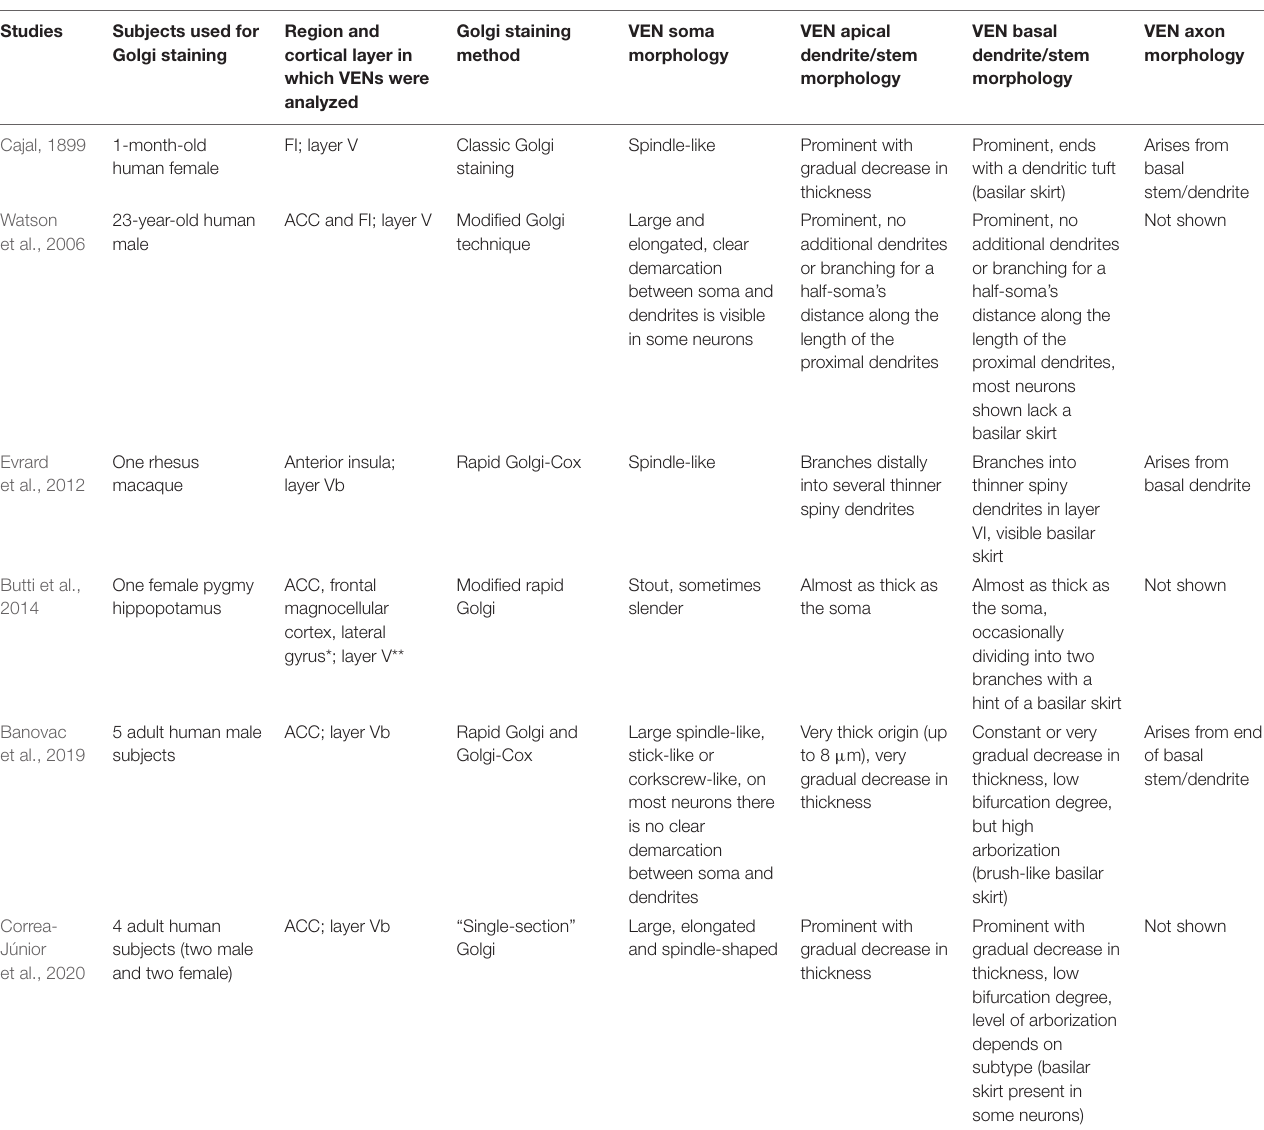
TABLE 3 | Studies visualizing VENs using Golgi